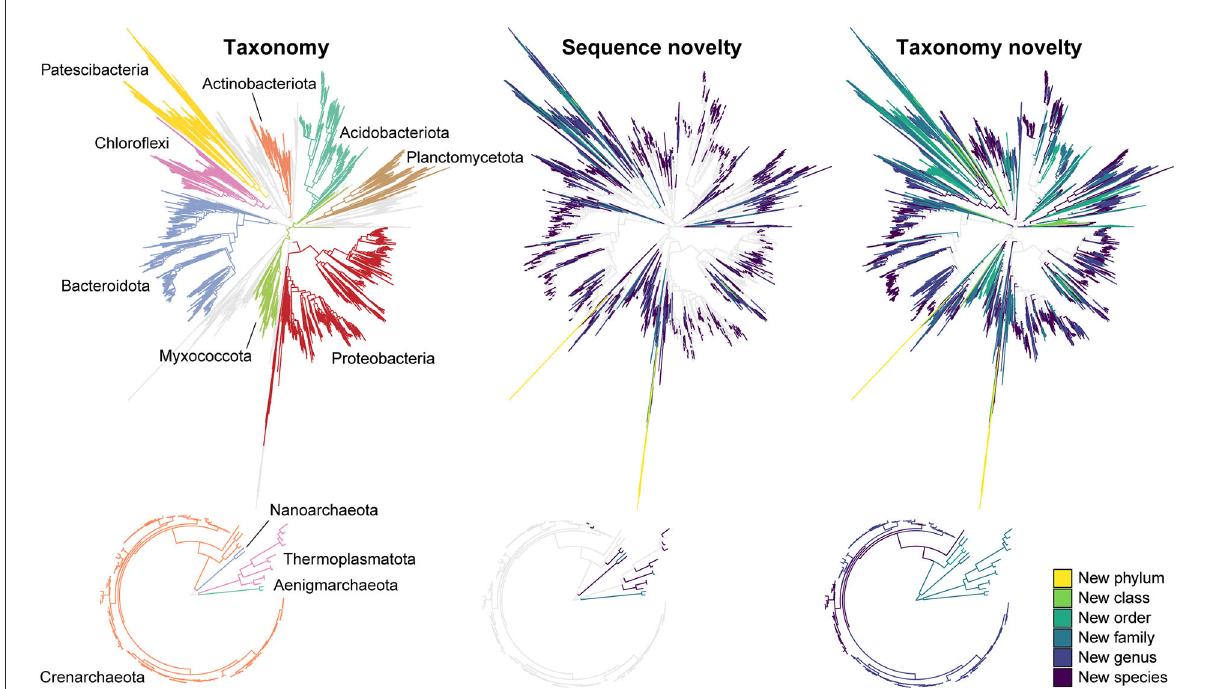
FIGURE1 Novel sequences and de novo taxa observed in the AsCoM reference database. Phylogenetic trees are based on the FL-ASVs in the AsCoM database. The eight phyla with the most FL-ASVs are highlighted. Sequence novelty was determined by the percent identity between each FL-ASV and their closest relative in the SILVA_138.1_SSURef_Nr99 database and taxonomic thresholds proposed by Yarza et al. (2014) shown in Table 1. Taxonomy novelty was defined based on the assignment of de novo taxa by AutoTax (Dueholm et al.,